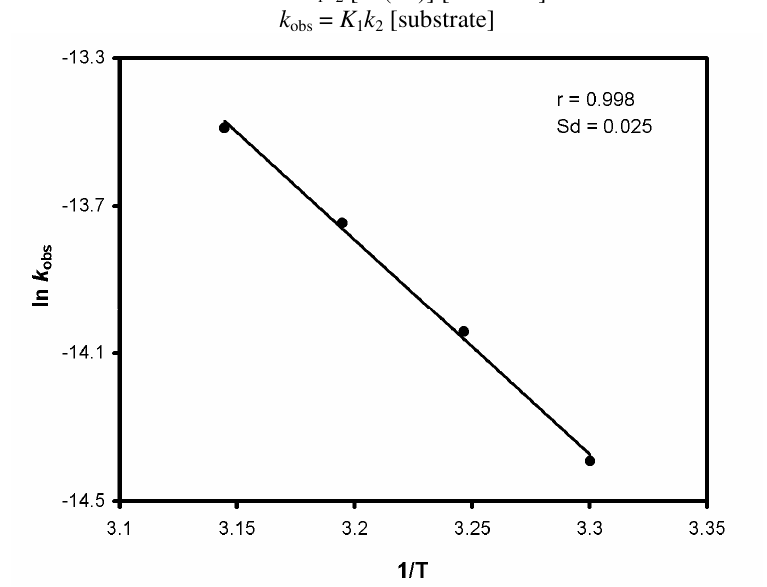
Figure 4 . Plot of ln k